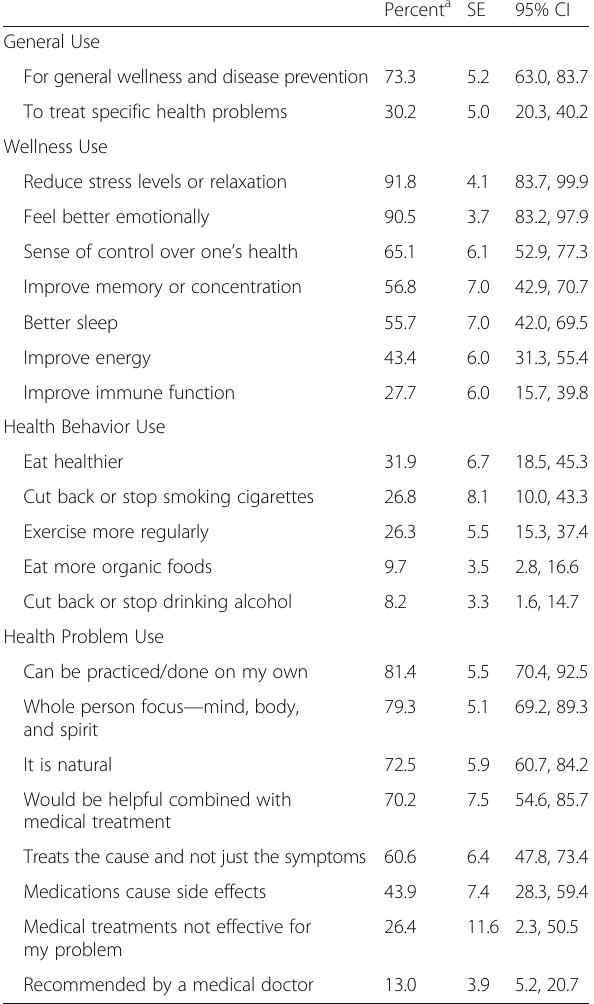
Percent a SE 95% CI